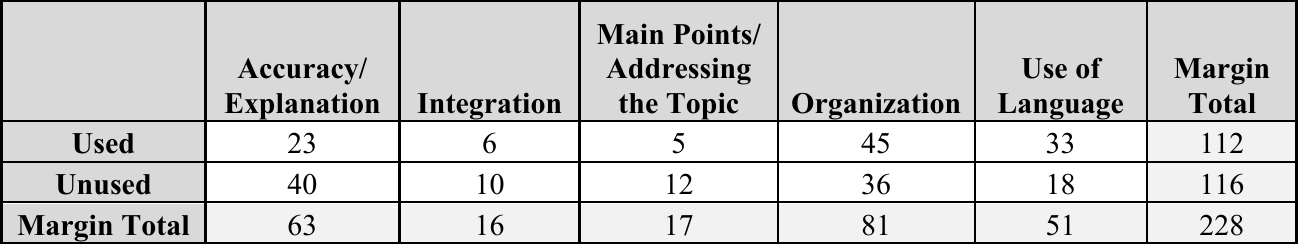
Frequency of Used and Unused Feedback by Rubric